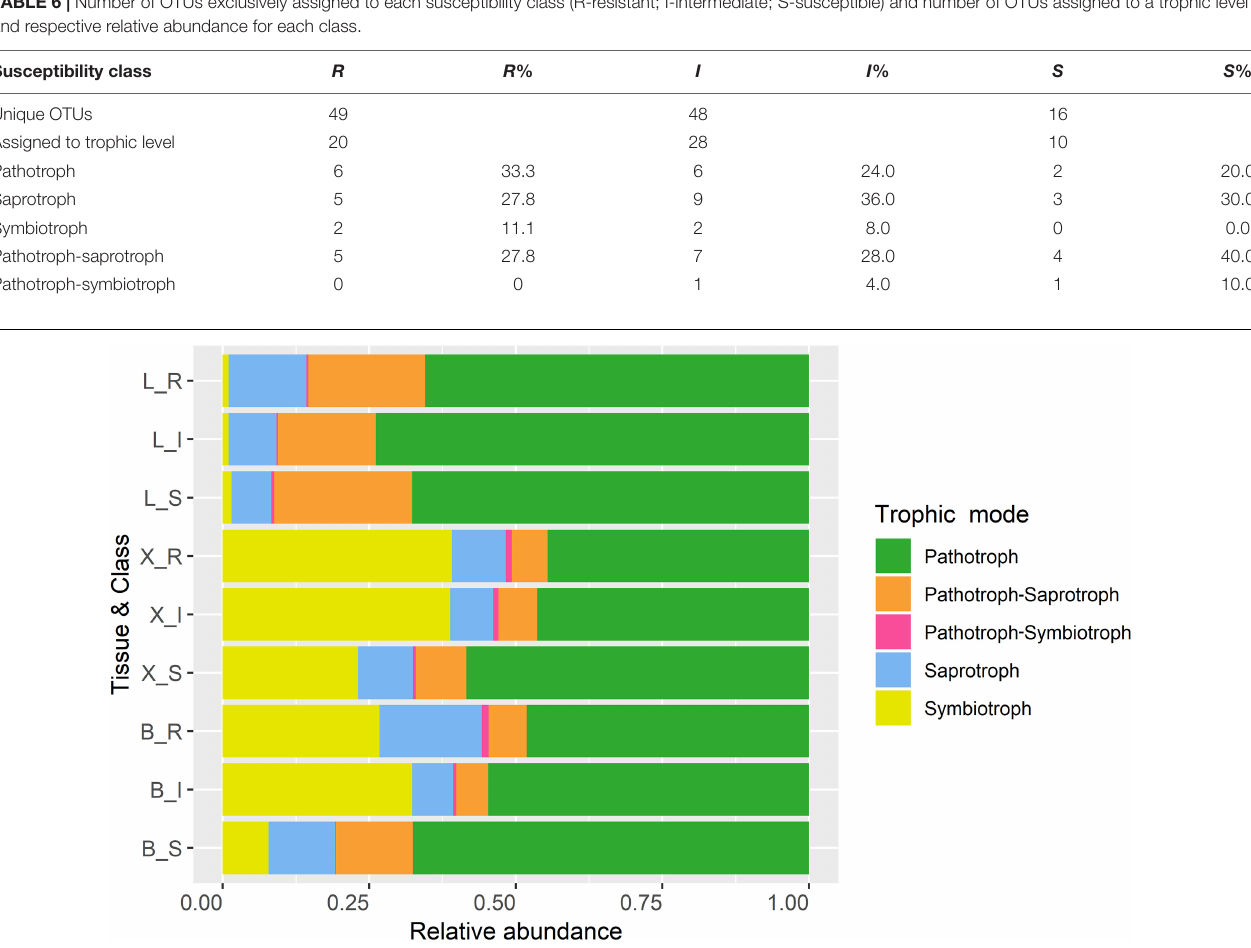
FIGURE 5 | Trophic modes of OTUs based on their relative read abundance for ash tissue types (L, leaves; X, xylem ; B, bark) and susceptibility class (R, resistant; I, intermediate; S, susceptible).